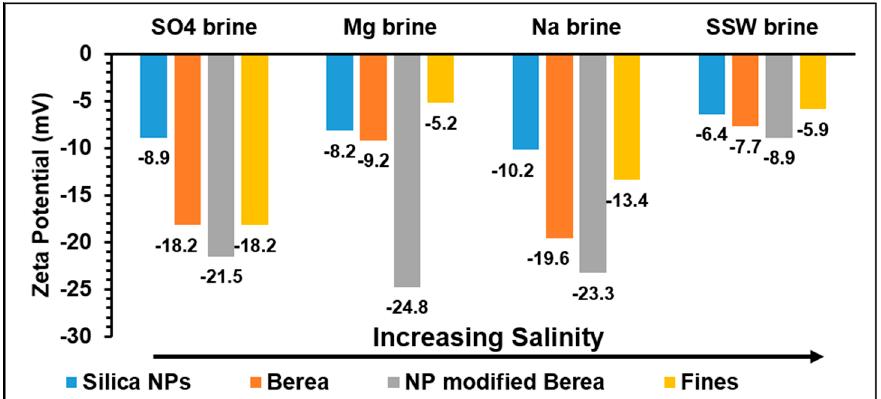
Figure 4. Zeta potential for the different fluids.